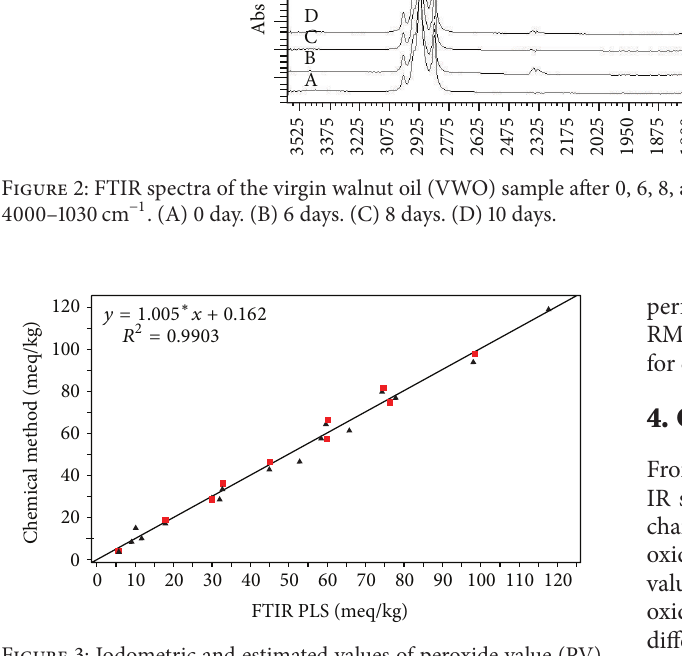
Figure 3: Iodometric and estimated values of peroxide value (PV) for calibration and validation sets ( 󳵳 : calibration set; ◼ : validation